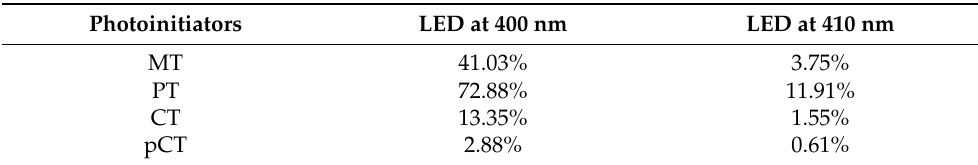
Figure 7. UV − Vis absorption spectra of photoinitiators extracted with DMF for 20 h from the photopolymers prepared by the photopolymerization of TMPTA under the irradiation of ( a ) LED at 400 nm and ( b ) LED at 410 nm in the presence of 10.0 µ mol/g triazine moiety of MT, PT, CT, and pCT in TMPTA. Table 3. The migration ratio of photoinitiators from photocured